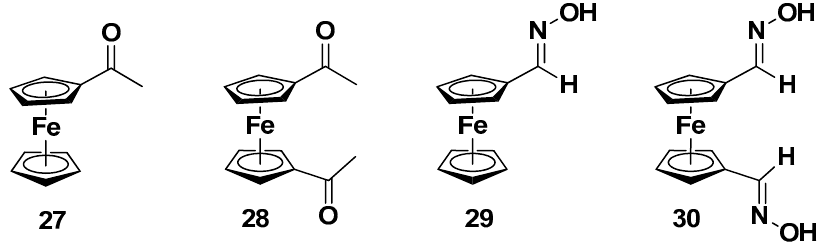
Figure 15. Structures of acetylferrocene ( 27 ), 1,1’-diacetylferrocene ( 28 ), ferrocenecarboxaldoxime ( 29 ), and ferrocene-1,1’-dicarboxaldoxime ( 30 ).